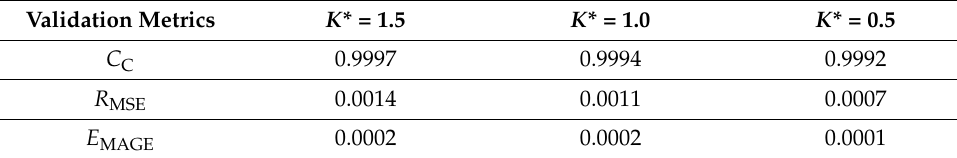
Figure 3. Comparison of present model and [11]. Table 1. Validation metrics between present study and